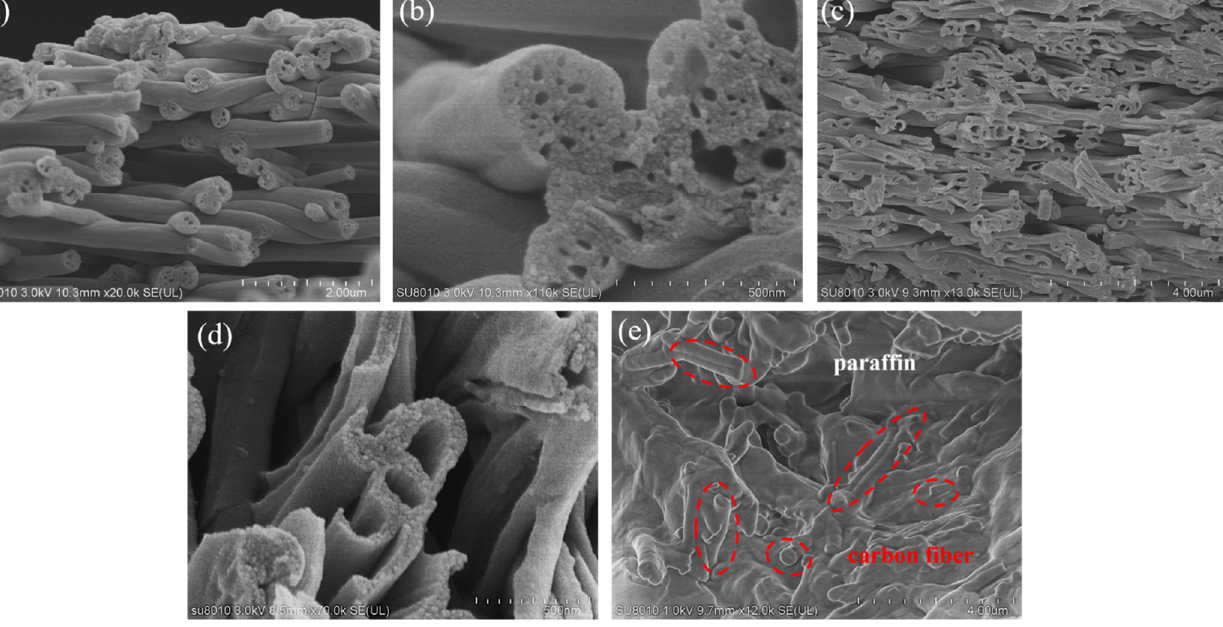
Figure 1. ( a , b ) Morphology of PCNF; ( c , d ) morphology of HPCNF; ( e ) morphology of the coaxial ring (red circles represent carbon fibers).